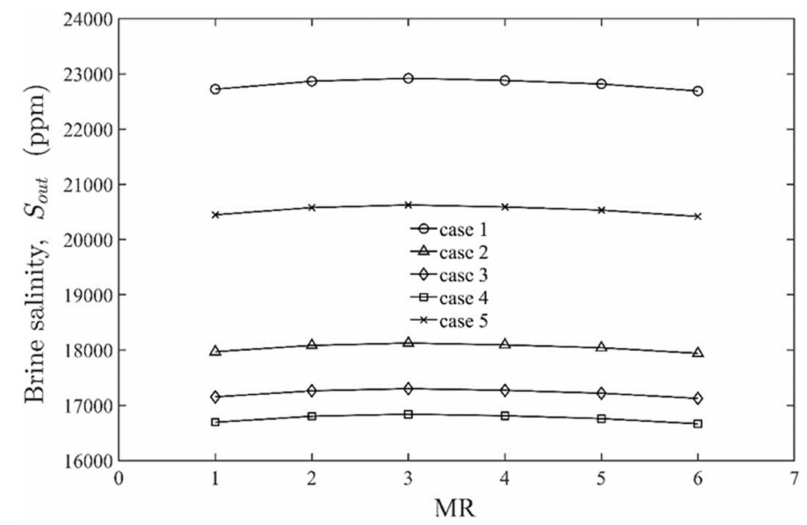
Figure 6. HDH brine salinity for different